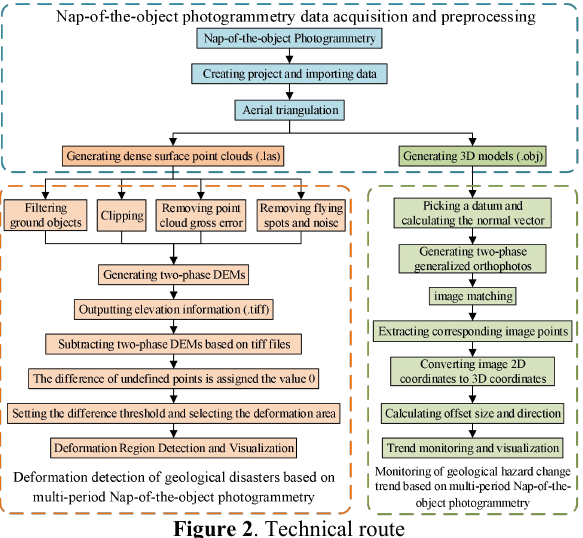
Figure 2 . Technical route